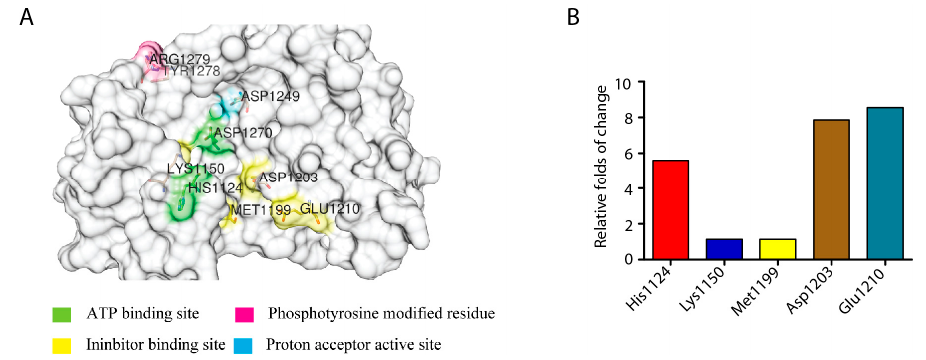
Figure 5. Amino acid residues affecting ALK activity. ( A ) Key amino acid residues affecting ALK activity identified by analyzing the trend of electrostatic energy change (PDB ID: 5AA8); ( B ) Relative folds of energy change of the identified key amino acid residues.